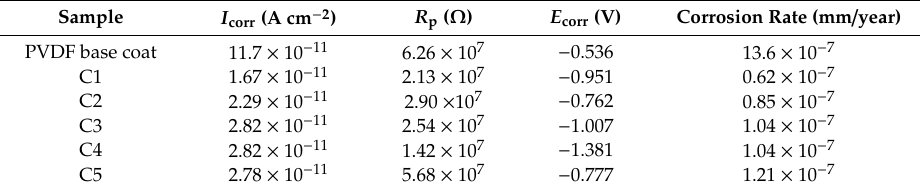
Table 3. Corrosion currents and the respective corrosion rates of the prepared coatings.